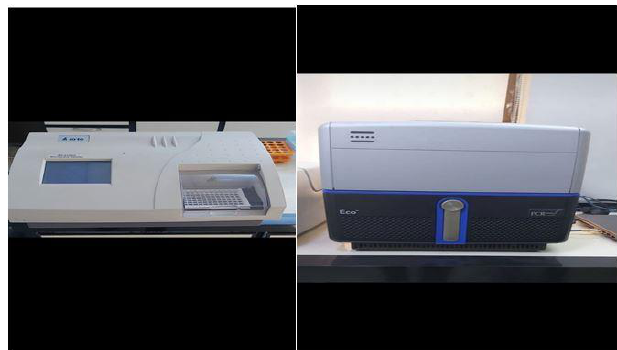
Fig.2: Polymerase Chain Reaction PCR device used in the study Gene expression analysis Tissue extraction